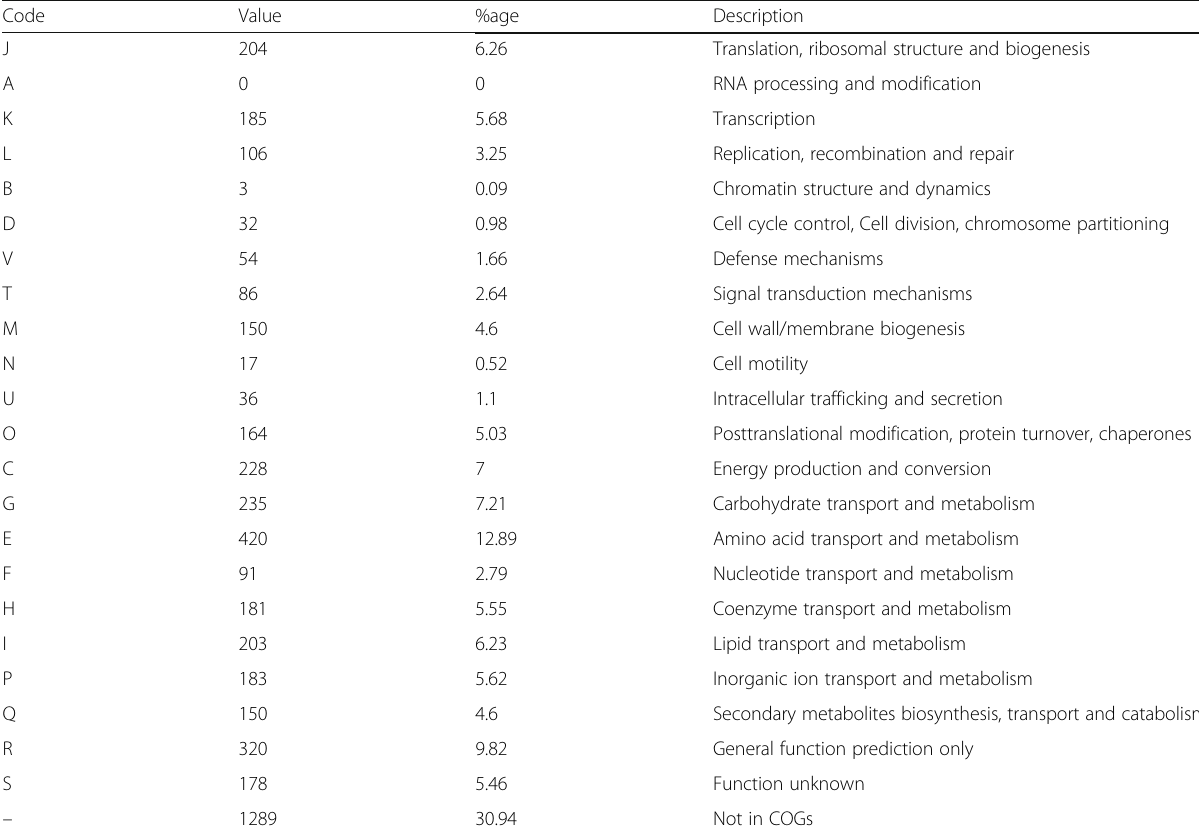
Table 4 Number of genes associated with general COG functional categories